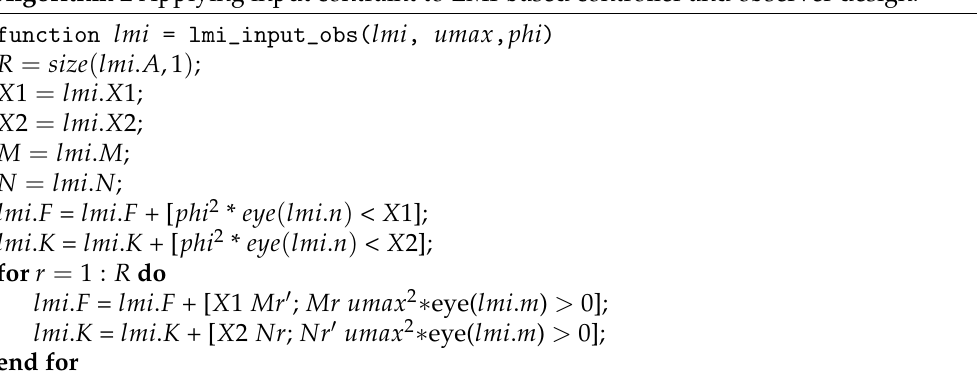
Algorithm 2 Applying input contraint to LMI-based controller and observer